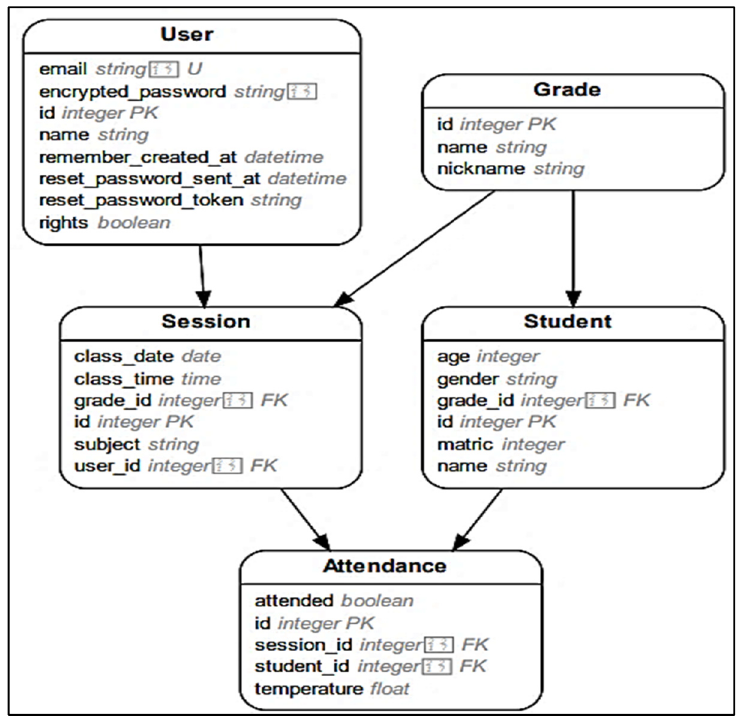
Figure 7. Entity Relationship Diagram of the Different Resources.